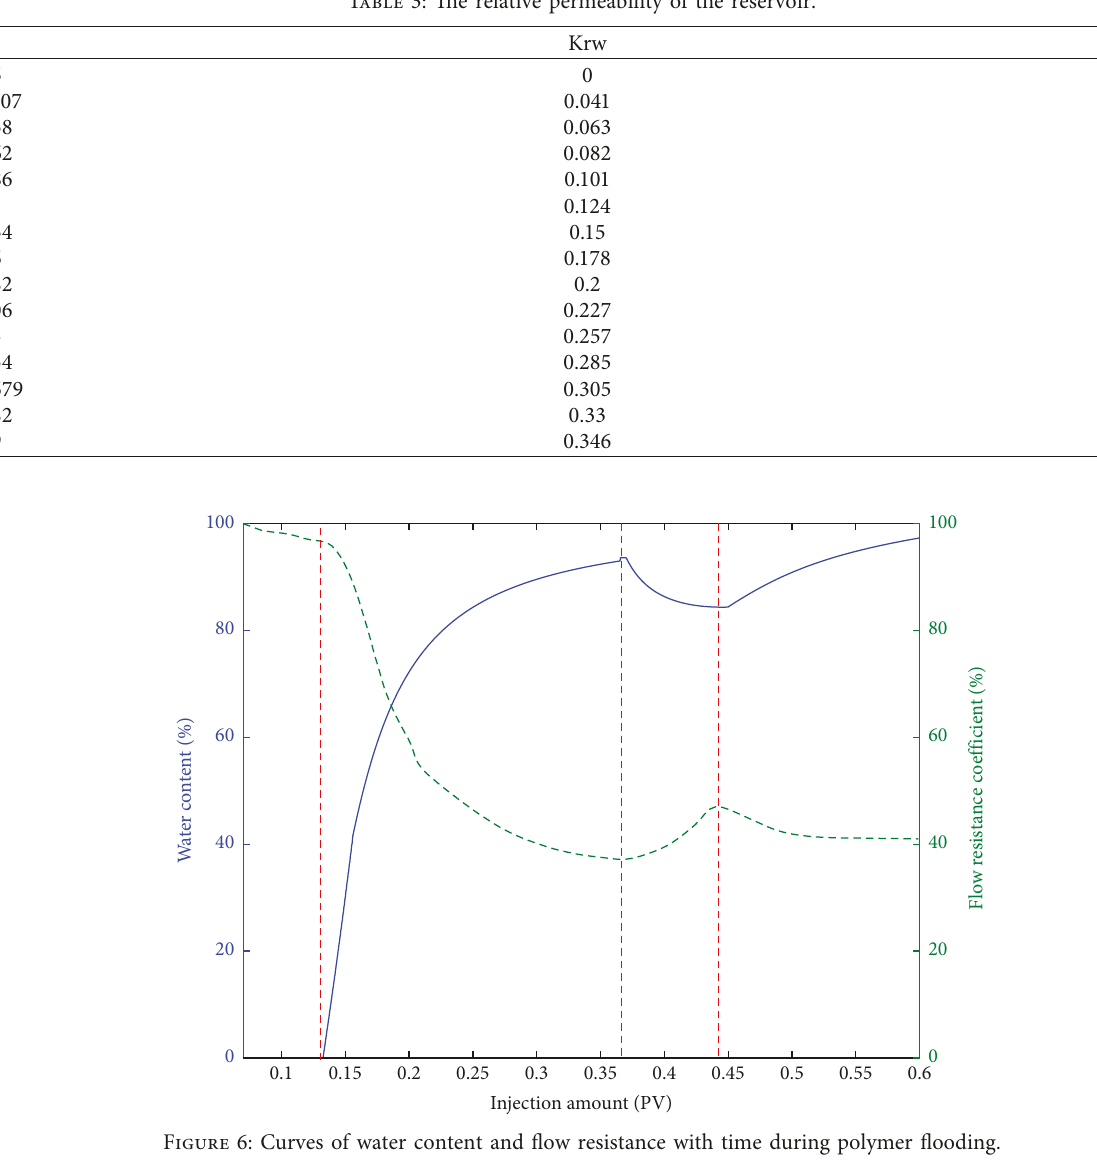
Table 3: The relative permeability of the reservoir.